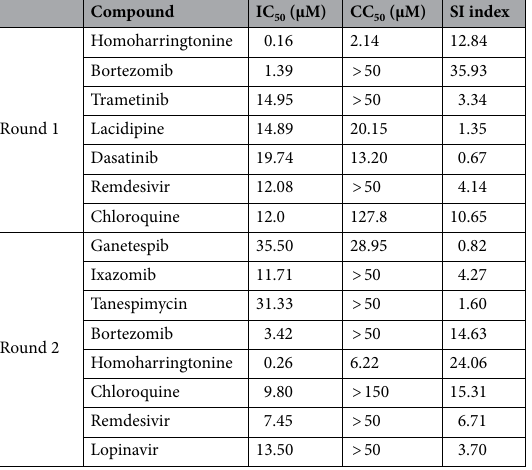
Table 1. Predicted anti-SARS-CoV-2 compounds in vitro efficacy testing from two independent rounds of testing. IC 50 , CC 50 , and SI index were calculated of each compound in SARS-CoV-2 infected in Vero cells. Homoharringtonine and bortezomib exhibited strong antiviral activities with corresponding cytotoxicity CC 50 at least 20 times higher than the viral killing IC 50